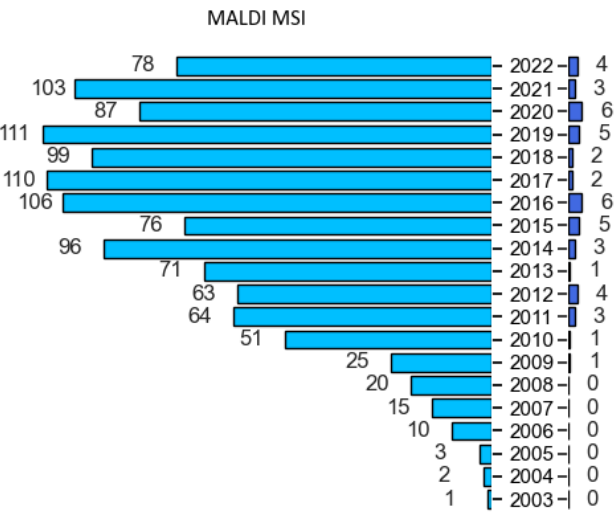
Figure 1. MALDI mass spectrometry imaging-related publications with the keywords “MALDI-MSI” or “MALDI mass spectrometry imaging” or “MALDI imaging” in Abstract or Title on PubMed search builder (searched in September 2022) compared to microbiology-related MALDI-MSI publications.